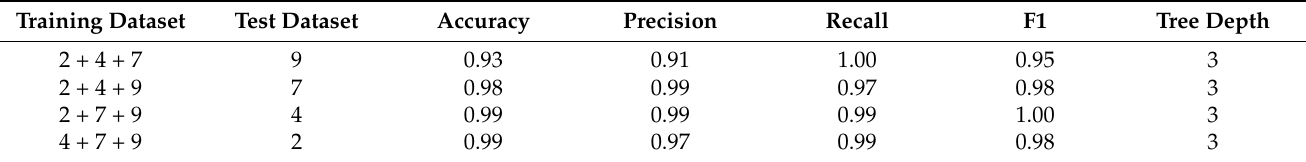
Table 7. Results using three datasets as training data.